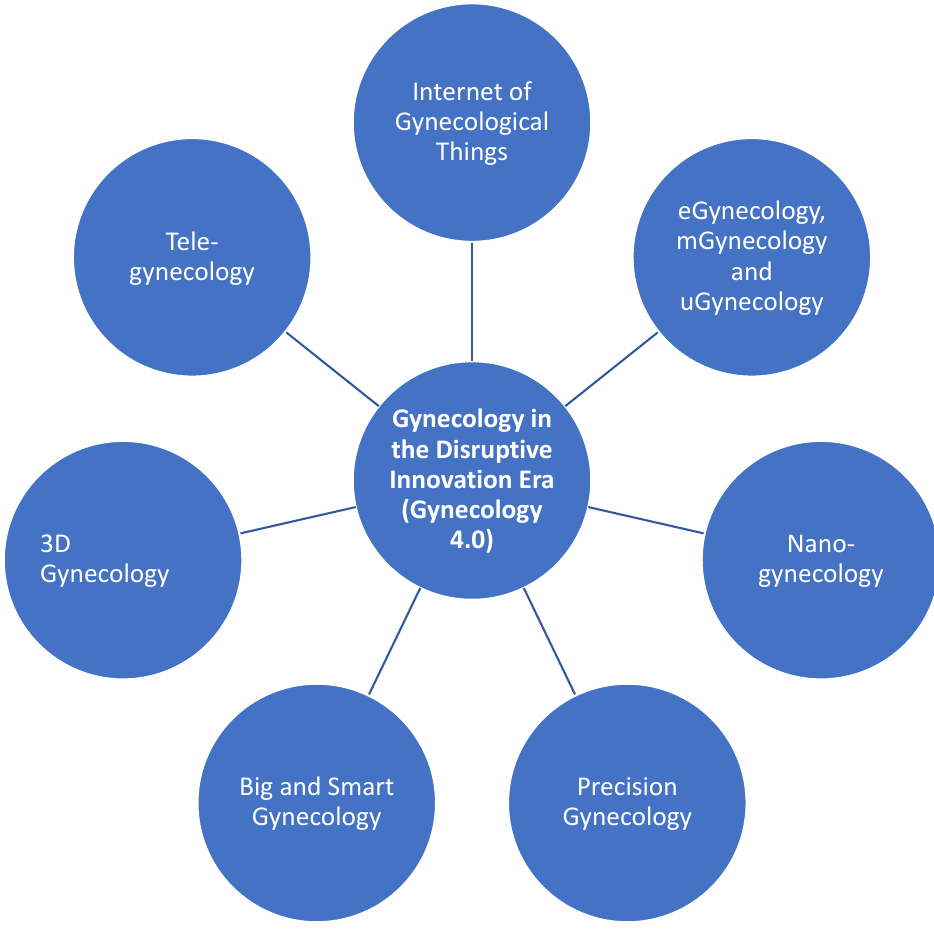
Figure 1. The convergence of advancements and progress from different fields (information and communication technologies, digitalization, molecular biology, biochemistry, biophysics, nano-engineering, and nano(bio)technology).